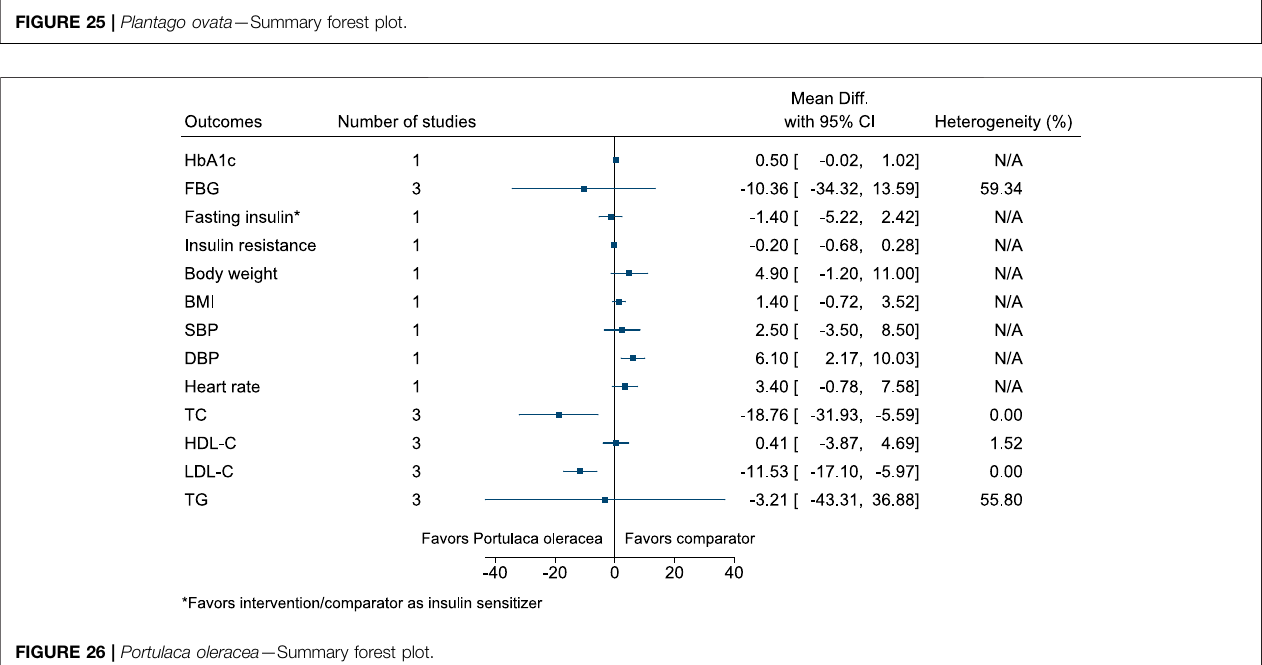
FIGURE 26 | Portulaca oleracea — Summary forest plot.